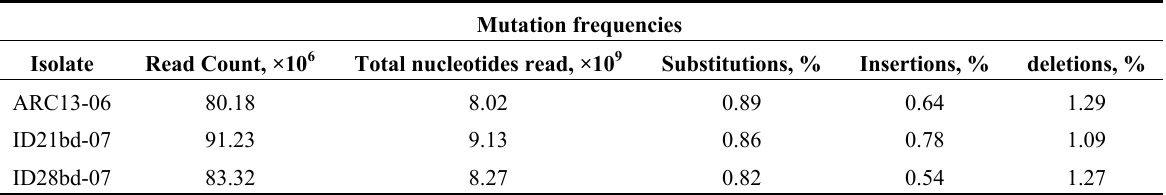
Table 3. Frequencies of mutations identified by HIVE for Illumina NGS data. Mutation frequencies Isolate Read Count, ×10 6 Total nucleotides read, ×10 9 Substitutions,